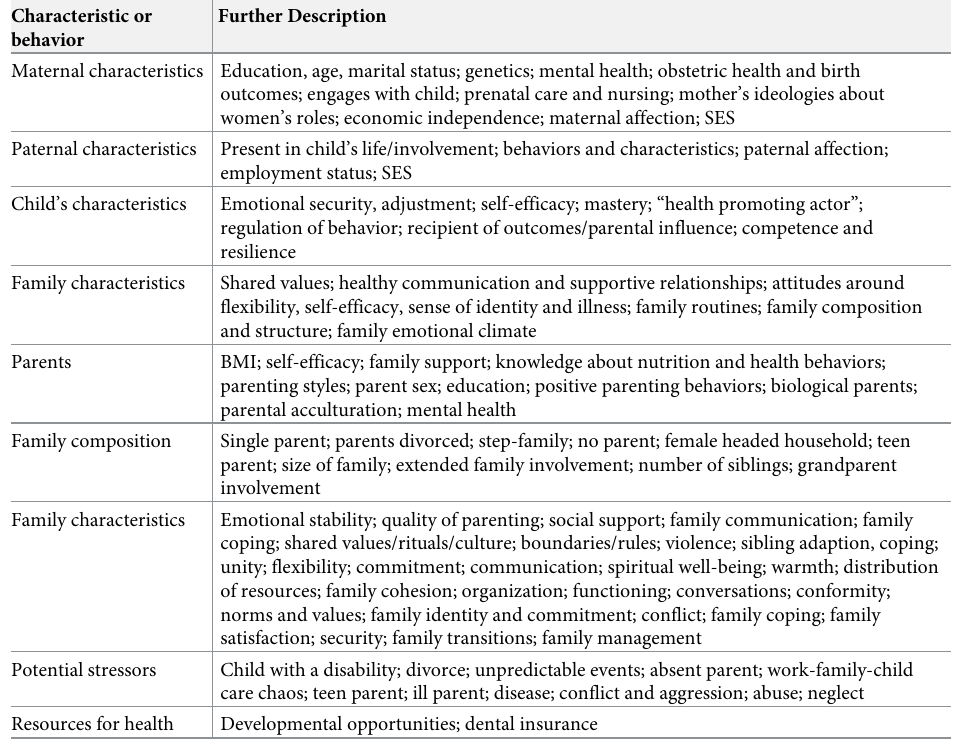
Table 3. Family characteristics and behaviors identified in the models.